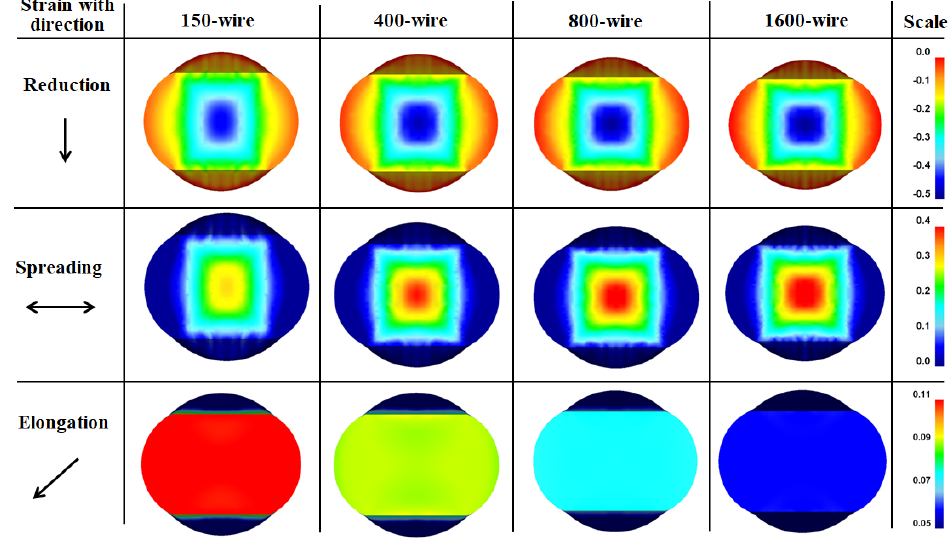
Figure 12. Comparison of the strain contours at three directions of the wire with the roll diameter.